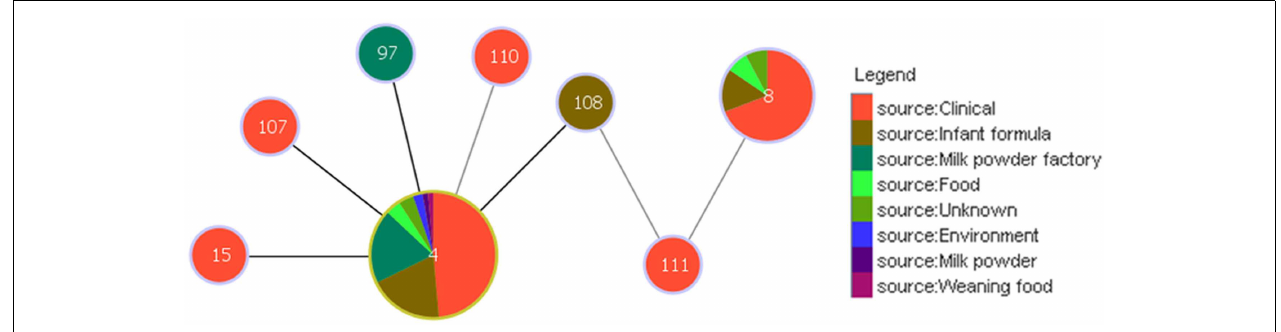
locus variation.The black lines denote the SLVs; while the gray lines indicate theTLVs. ST4 is the founder clone of the clonal